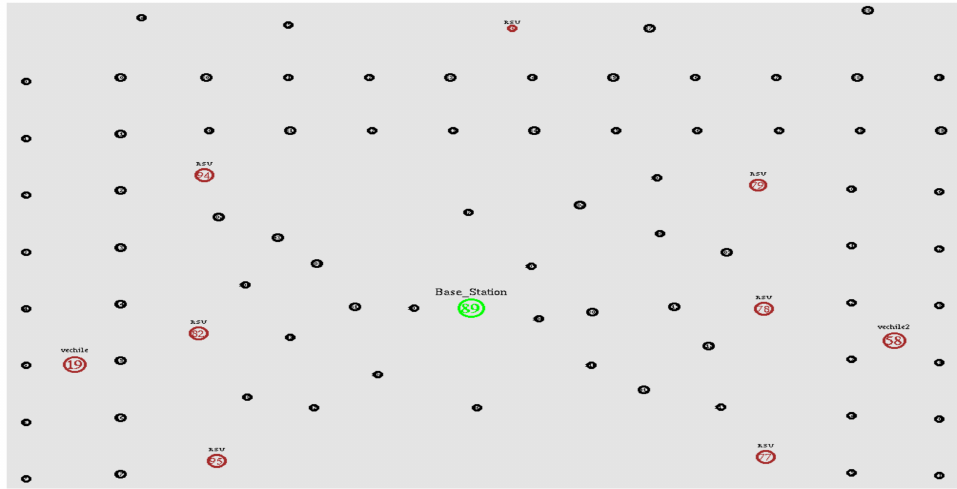
Figure 8. Simulation scenario with 98 nodes.